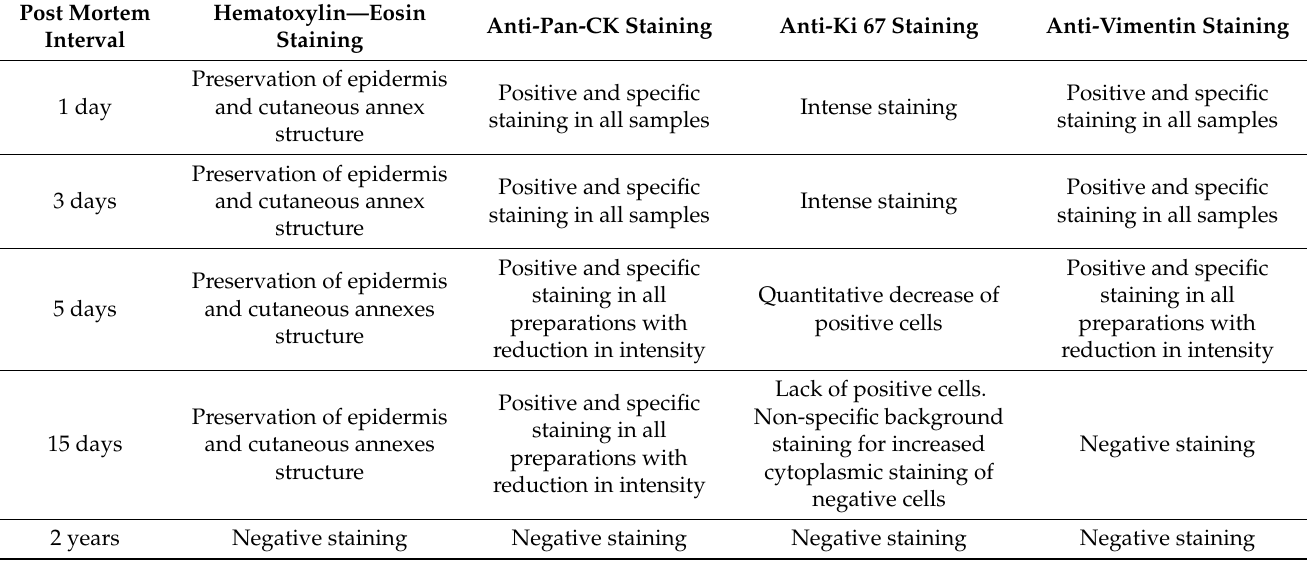
Figure 8. Immunohistochemical analysis of CD20. ( A ) CD20 positive cells in a spleen taken 2 days after death, 10×; ( B ) the CD20 staining became faint and less specific 5 days after death, 40×. ( C ) Graph shows the intensity of CD20 immunostaining in the spleen (score 0 – 3). Tables 2 – 5 summarize the results of immunohistochemistry in the tissues analyzed. Table 2. Immunohistochemical evaluation of cytokeratin, ki67, and vimentin in skin tissues.